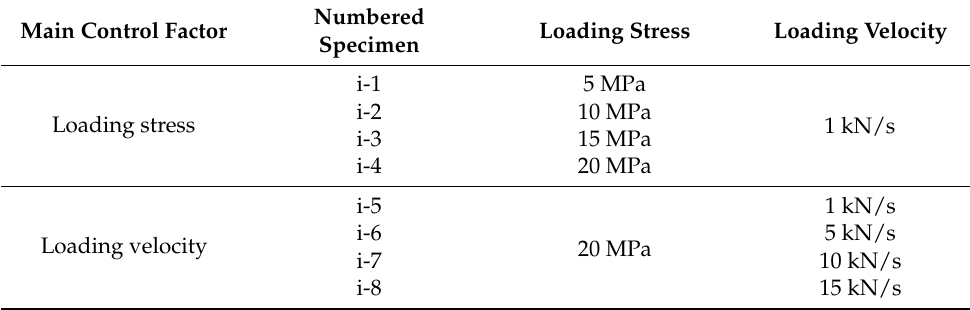
Table 1. Single-factor rotation test scheme.